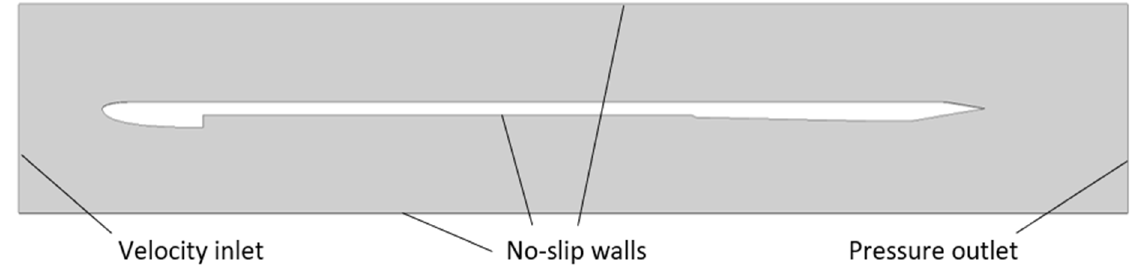
Figure 3. Numerical domain and boundary conditions.